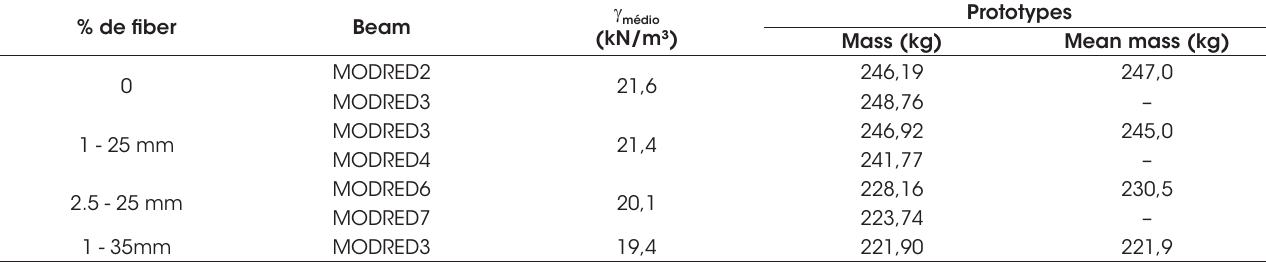
Specific weight and estimated mass of the sleeper prototypes